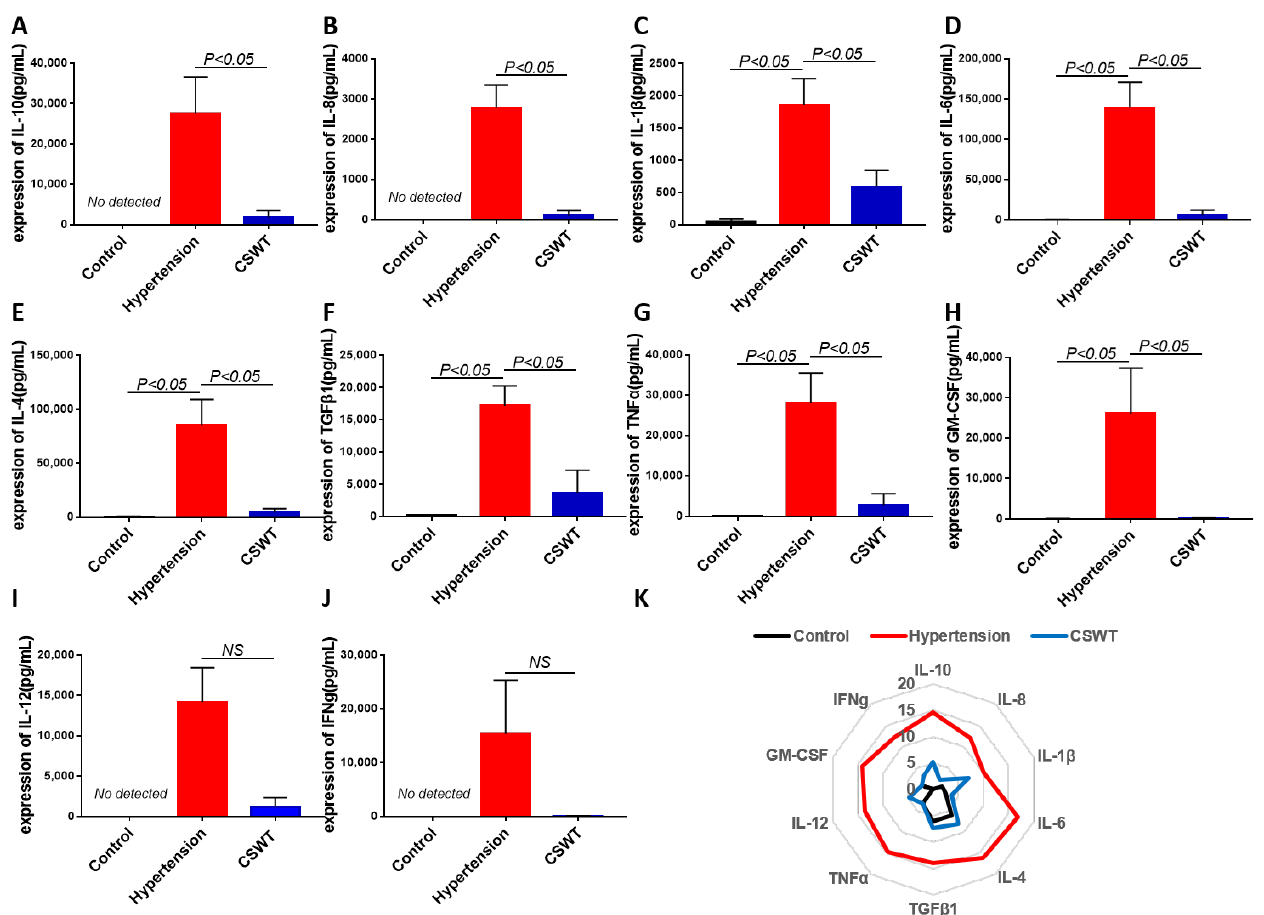
Figure 6. Anti-inflammatory effect of CSWT at the 20th week. The level of circulating cytokines was detected using cytokine array in the control, hypertension and CSWT groups (N = 4 for each group) at the 20th week. ( A – J ). After induction of hypertension, expression of IL-1 β , IL-6, IL-4, TGF β 1, TNF α and GM-CSF significantly increased in hypertension group compared with control group, and the level of expression of IL-10, IL-8, IL-12 and IFNg was not detected in the control group. Expression of IL-10, IL-8, IL-1 β , IL-6, IL-4, TGF β 1, TNF α and GM-CSF significantly decreased in the CSWT group compared with the hypertension group. There was no significant difference of expression of IL-12 and IFNg between hypertension group and CSWT group. ( K ). Expression of cytokines was detected using cytokine array in the control, hypertension and CSWT groups at the 20th week. Independent Student t -test and one-way ANOVA were used. NS: not significant.